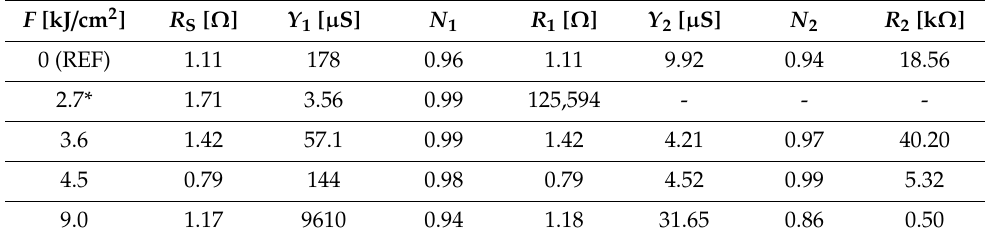
Table 3. Impedance parameters of aluminium 5754 alloy in 3.5% NaCl solution, where: R S —solution